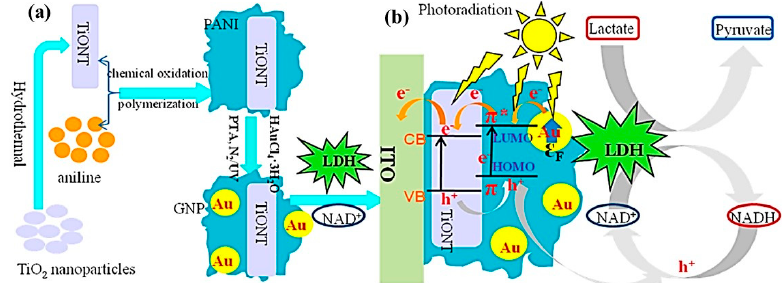
Figure 6. ( a ) Schematic illustration of the preparation of TiONT-PANI-GNPs ternary composites; ( b ) surface plasmon resonance (SPR)-enhanced photoelectrochemical (PEC) detection of lactate at the TiONT-PANI-GNPs|LDH|NAD+|ITO (indium tin oxide) coupling with PEC coenzyme regeneration. Reprinted with permission from [47]. Copyright 2015, American Chemical Society. LDH: lactate dehydrogenase.